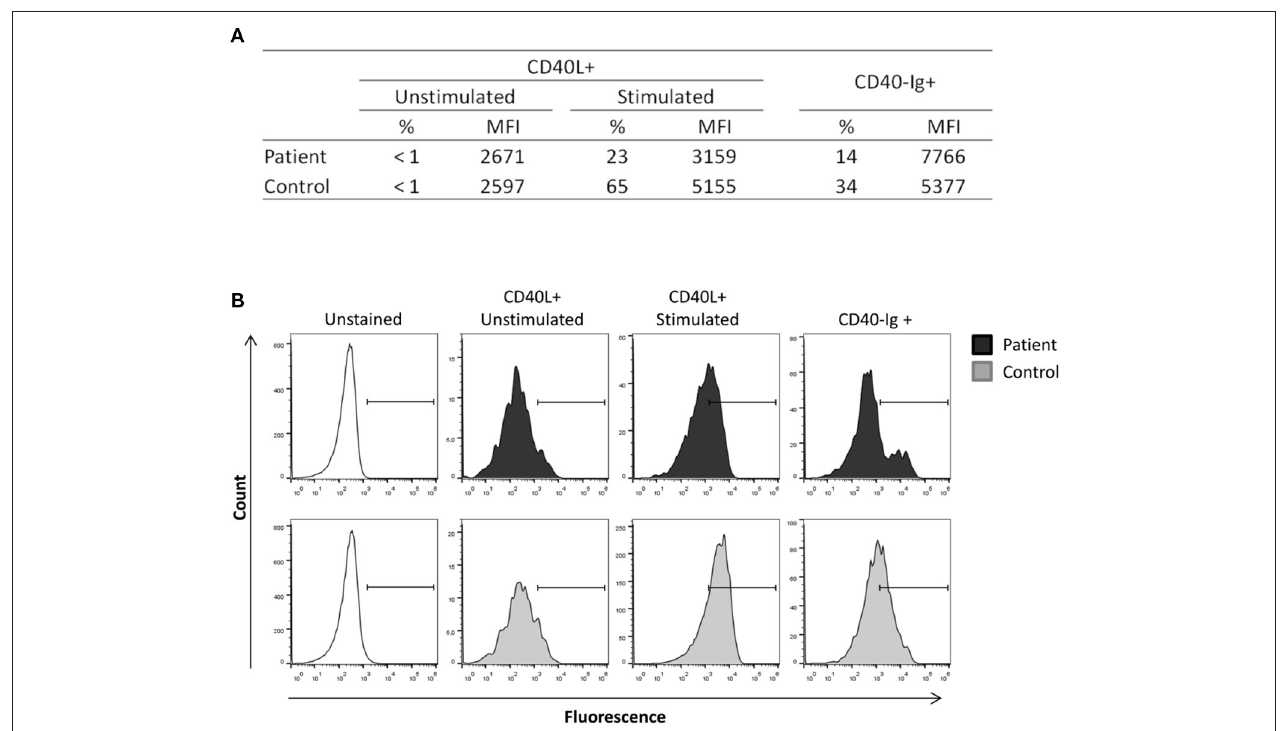
FIGURE 1 | CD40L expression in activated lymphocytes. Peripheral blood mononuclear cells from the patient and a healthy control were stimulated with ionomycin (1 µ g/mL) and PMA (20ng/mL) for 3h, and non-adherent cells were then collected, stained and analyzed by flow cytometry. CD40L expression and CD40Ig binding were analyzed in CD3 + CD4 + gated cells. (A) The patient exhibited reduced expression of CD40L after stimulation compared with that seen in the healthy control and displayed reduced CD40-Ig binding. (B) Representative histograms showing the reduction of CD40L expression and CD40Ig binding in the patient. The experiments were performed in duplicate and repeated twice with two distinct healthy